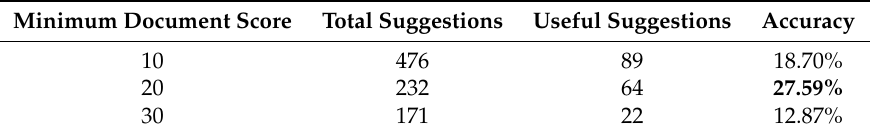
Table 1. Base approach – minimum document score impact.